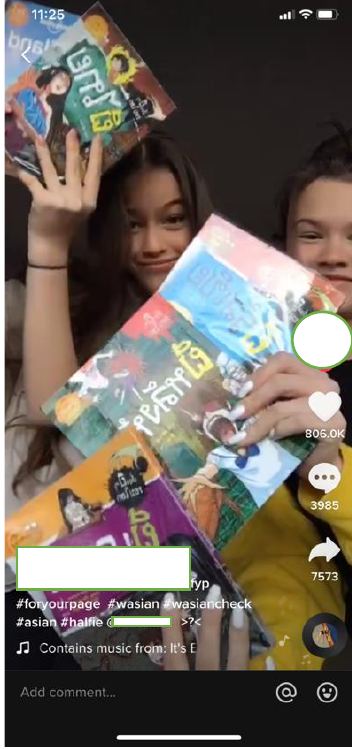
Figure 8. Asian Language Books.